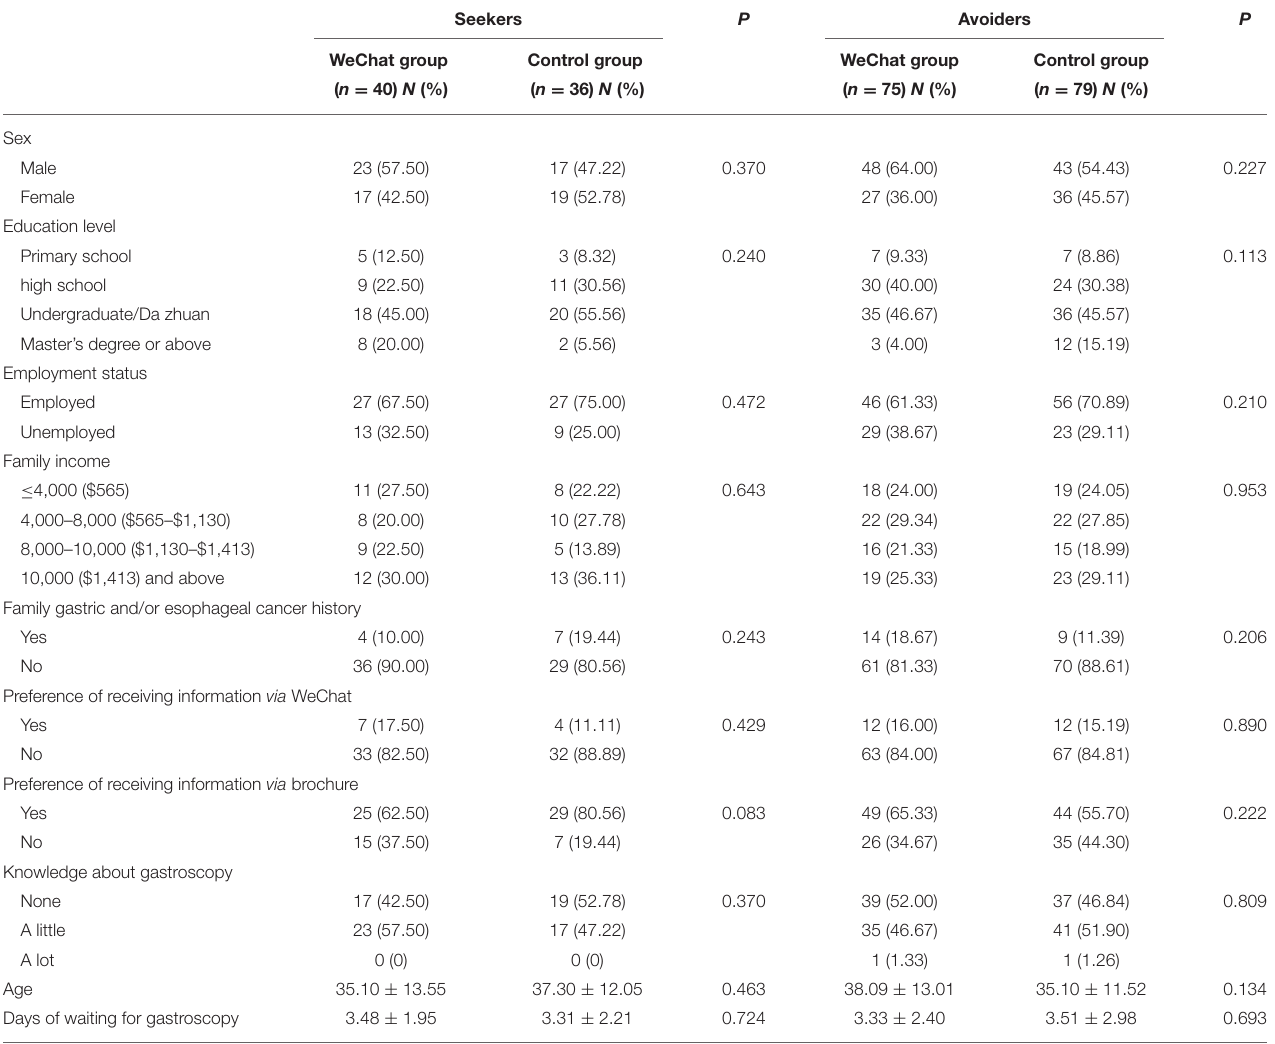
TABLE 1 | Baseline characteristics of patients undergoing gastroscopy included in the study. Seekers P Avoiders P WeChat group Control group WeChat group Control